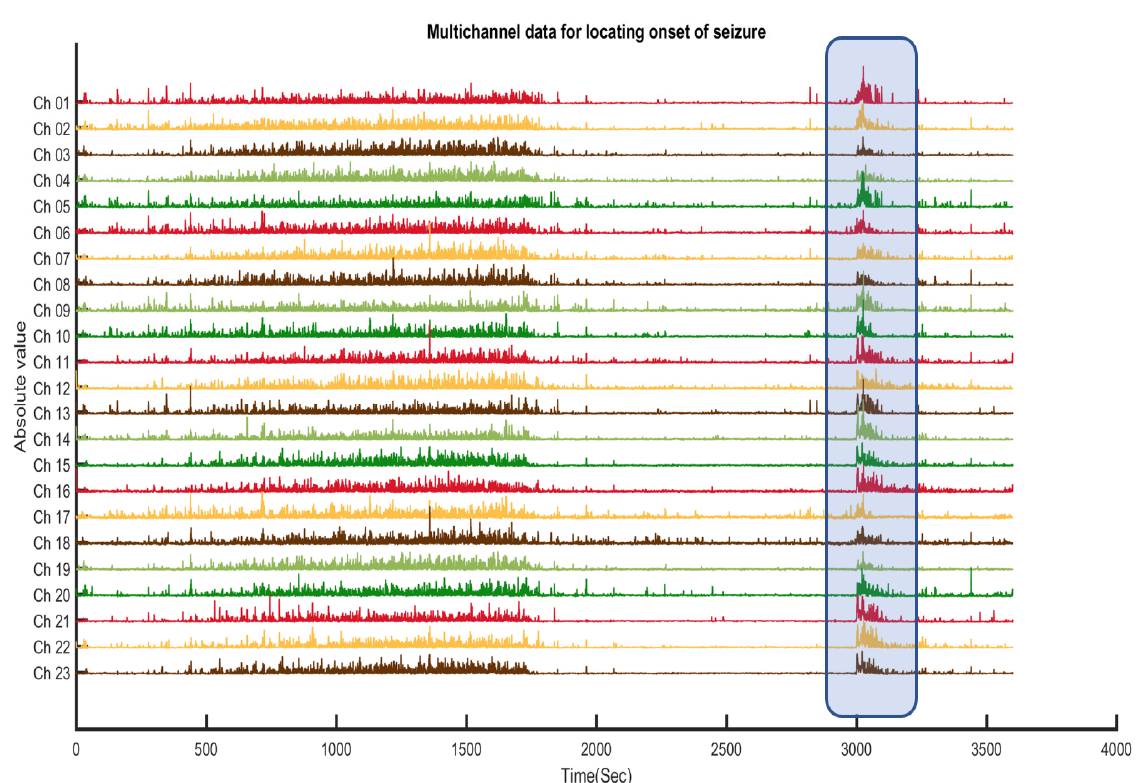
Figure 6. Feature showing the onset of seizure marked in the output window for chb01_26, using the proposed seizure-detection algorithm.